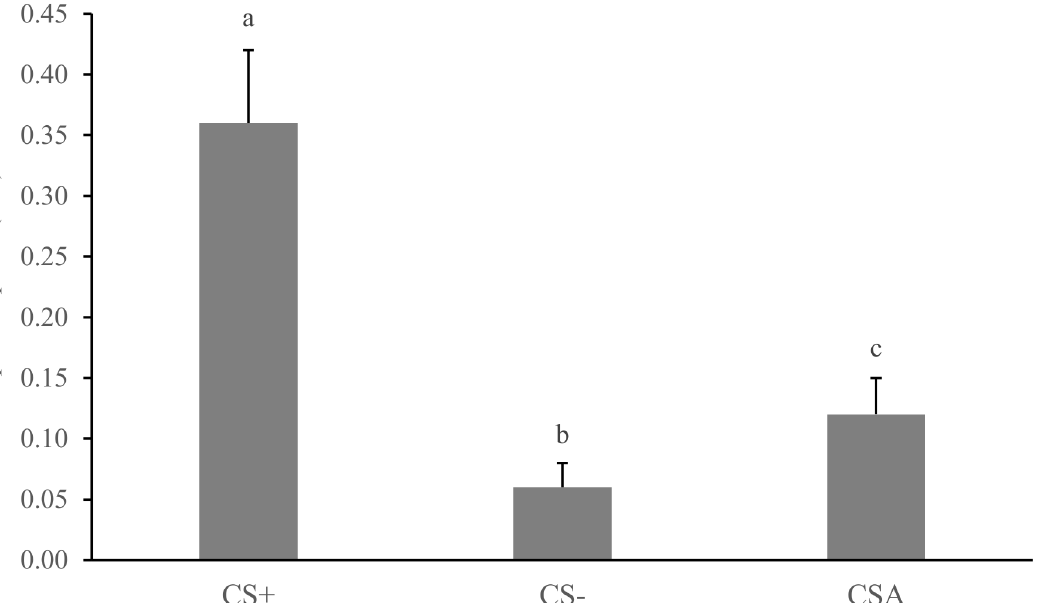
Fig 3. The average (+ SE) speed of responses (m/s) of white-lipped peccaries approaching the feed dispenser according to cue type (CS+, CS-, CS A ). Different letters (a 6¼ b) represent significant differences and same letters indicate non-significant